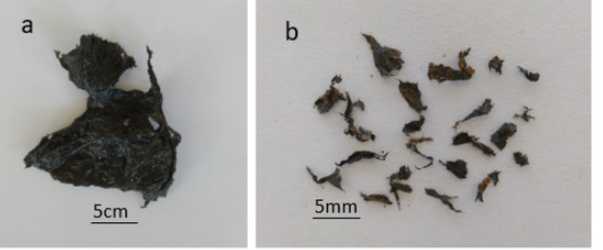
Figure 5. The debris of black plastic mulch films—( a ): piece of plastic mulch film, ( b ): microplastics collected from soil after removal of mulch film. Adapted from [67].